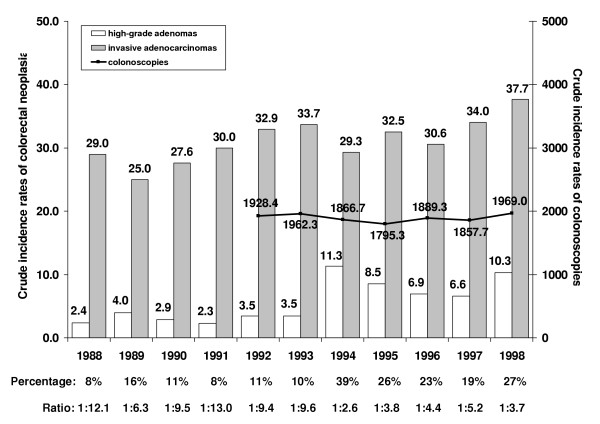
Crude incidence rates and colonic high-grade adenoma / invasive adenocarcinoma-ratio in comparison to colonoscopies: 1988–1998; both genders; n = 254*/1379 cases (*diagnoses by biopsy only included).